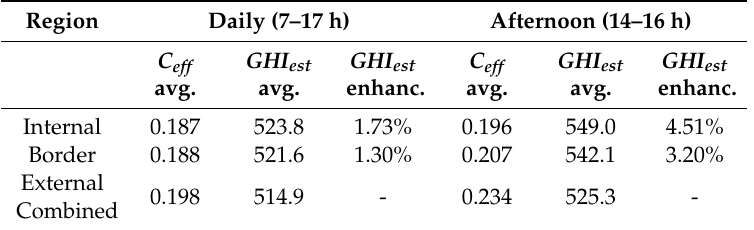
Table 7. Comparison of annual mean e ff ective cloud cover index, C ef f , and respective estimates of mean surface incoming solar irradiance ( GHI est ) at the water surface and external areas of the Serra da Mesa Hydropower Reservoir. The incoming global solar irradiance in external areas was the reference value to calculate the irradiance enhancement. Morning di ff erences were not significant (not shown).